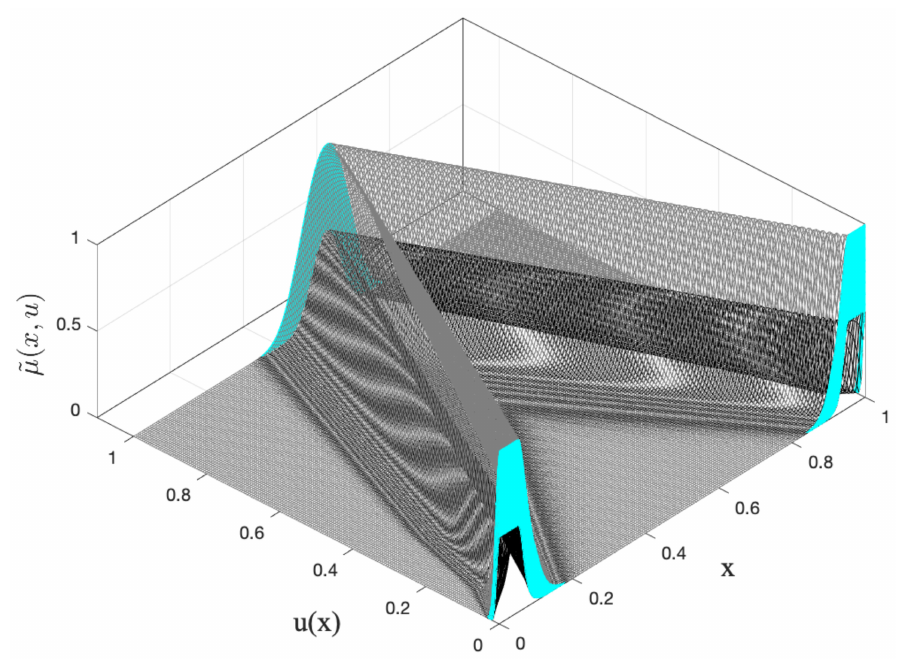
The membership function by which the fuzzy system is composed is ScaleTriScale- GaussT3MF, the visual representation of the MF is presented in Figure 4 and its mathemati- cal representation is expressed in Equation (30).